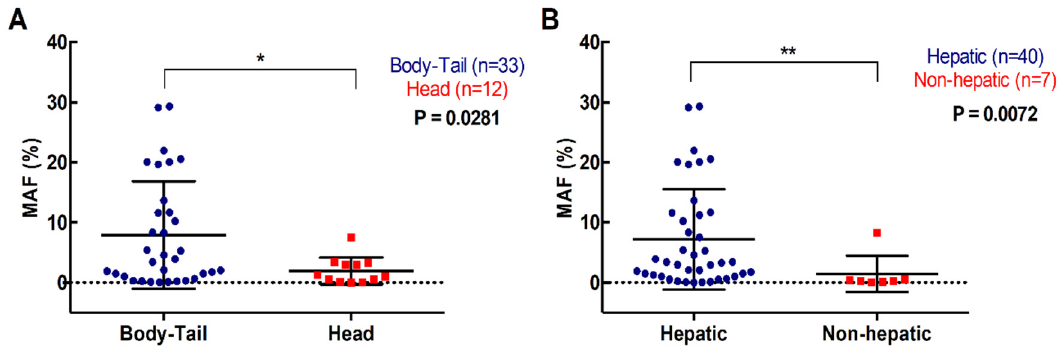
Figure 3. Overall and progression free survival rates according to circulating RAS mutation allele fraction (MAF). ( A ) OS according to circulating MAF (cut-off: 0.351%); ( B ) PFS according to circulating MAF (cut-off: 0.351%).